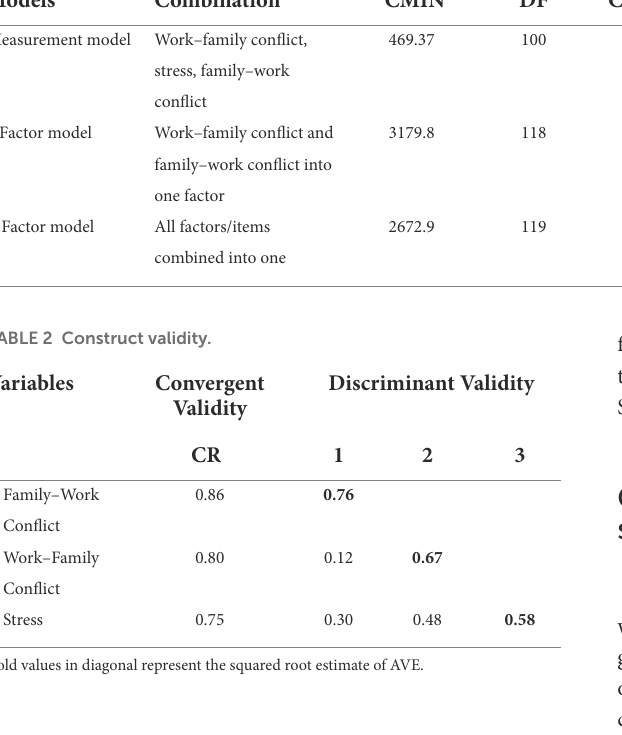
(parametric test: ANOVA) to figure out the difference between five groups on the basis of work-to-family conflict, stress, and